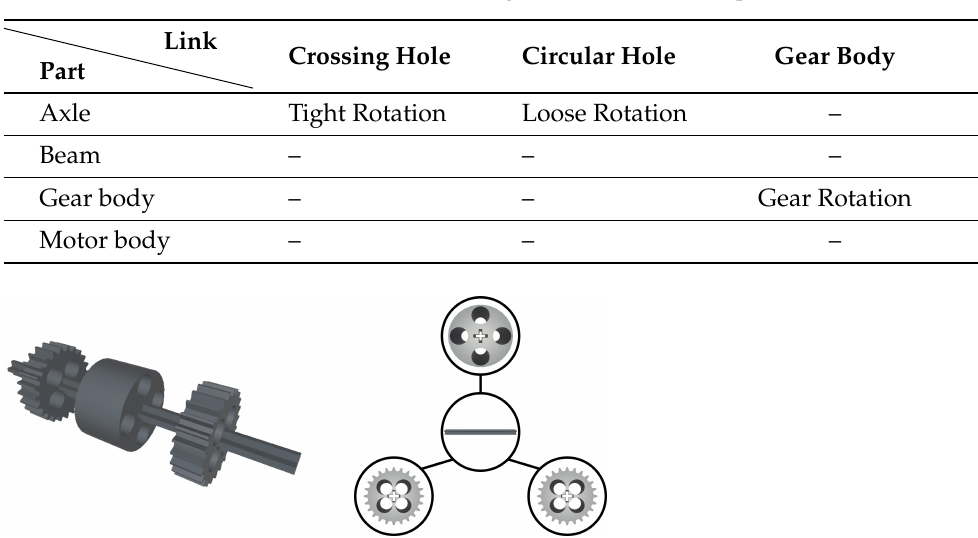
Table 1. Allowable connections between connecting links and mechanical parts.